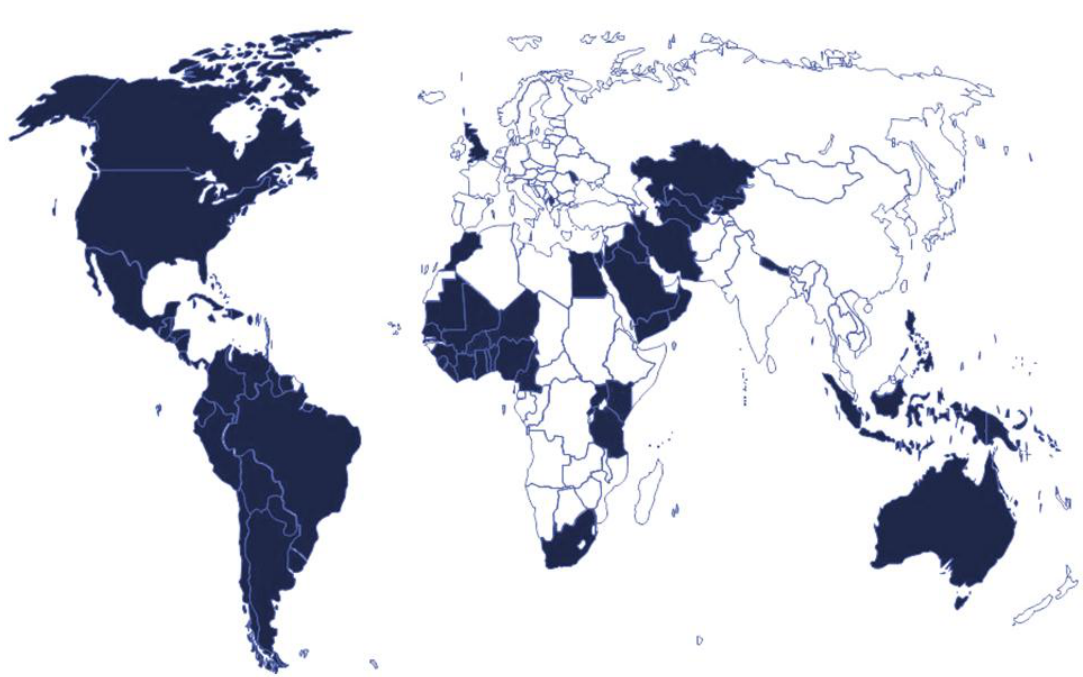
Figure 2. Grain Fortification Legislation—Countries in blue require fortification of wheat flour, maize flour, and/or rice (November 2013. Source: Flour Fortification